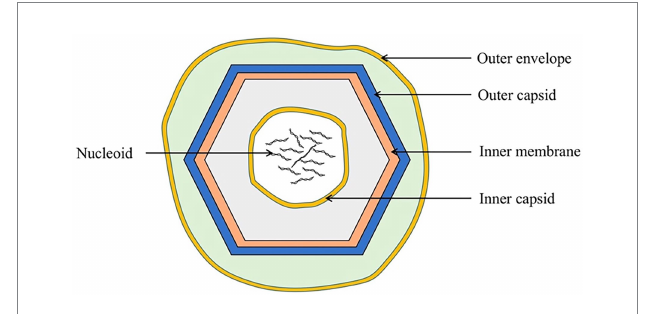
FIGURE 1 Schematic diagram of the ASFV structure. ASFV is composed of an external envelope, outer capsid, inner membrane, inner capsid, and